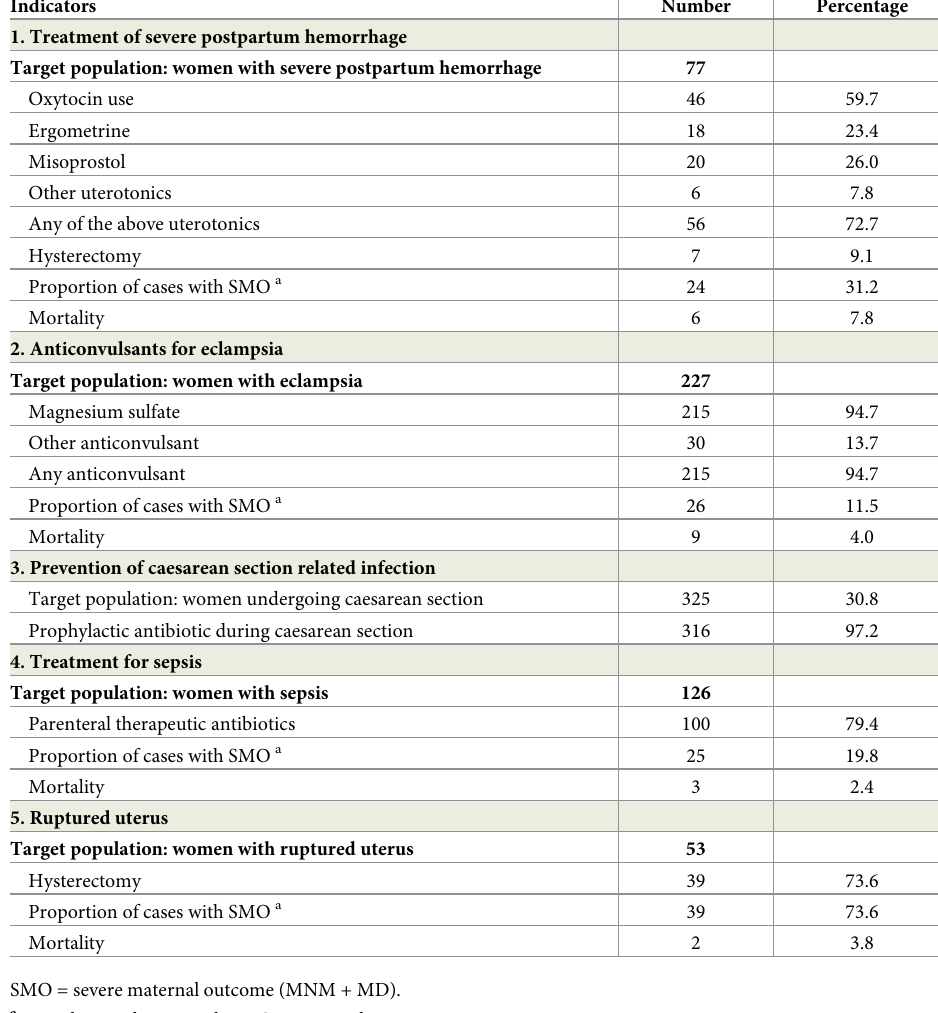
Table 6. Process and outcome indicators related to specific conditions among women with SMO in eastern Ethio- pia, 2017. Indicators Number Percentage 1. Treatment of severe postpartum hemorrhage Target population: women with severe postpartum